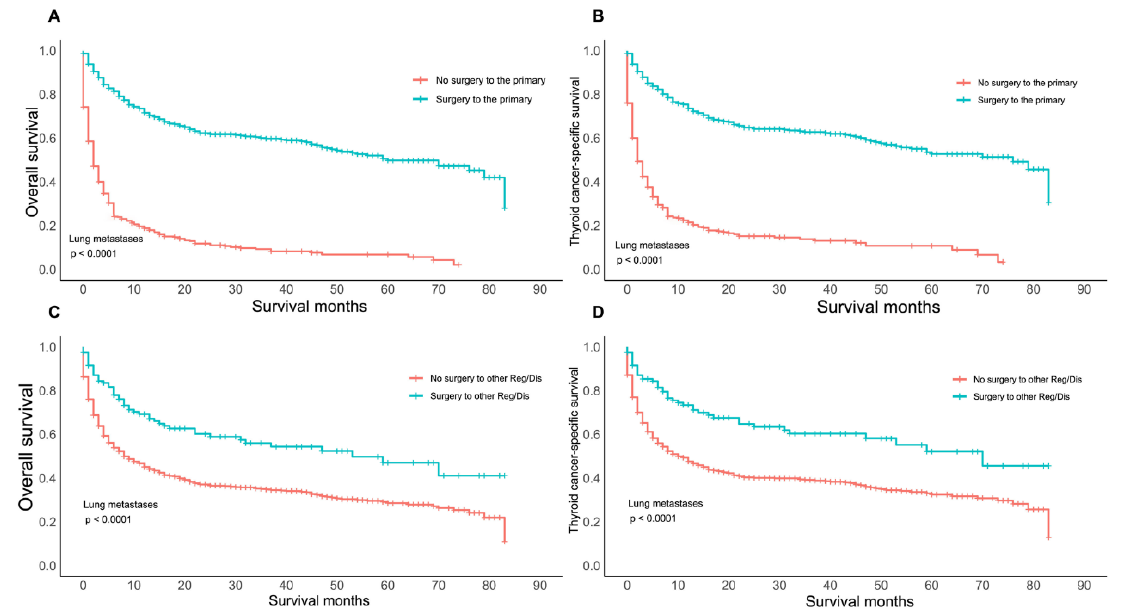
Figure 3. Kaplan–Meier curves of overall survival and thyroid cancer-specific survival according to whether or not surgery of the primary TC lesion and distant metastatic lymph nodes (LN) or lung metastasis was performed. ( A ) Overall survival for patients with isolated lung metastasis with or without surgery of the primary tumor. ( B ) Thyroid cancer-specific survival for patients with isolated lung metastasis with or without surgery of the primary tumor. ( C ) Overall survival for patients with isolated lung metastasis with or without surgery of the distant lymph nodes (LNs) or other metastatic sites. ( D ) Thyroid cancer-specific survival for patients with isolated lung metastasis with or without surgery of the distant lymph nodes (LNs) or other metastatic sites.